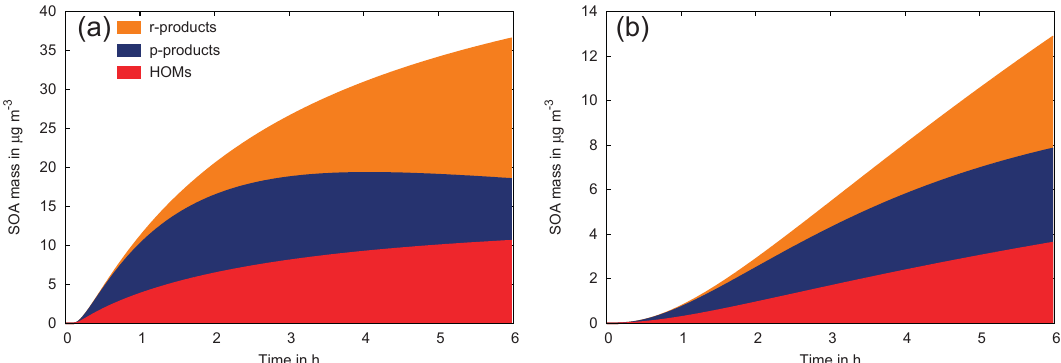
Figure 5. Simulated SOA mass including HOMs resolved for the different components for (a) liquid aerosol particles ( D b = 10 − 12 m 2 s − 1 ) and (b) the transition between liquid and semi-solid ( D b = 10 − 14 m 2 s − 1 ) aerosol particles and k c = 10 − 4 s − 1 . Therein, p-products represent compounds which are partitioned from the gas phase into the particle phase, and the r-phase includes compounds which are chemically processed by particle-phase